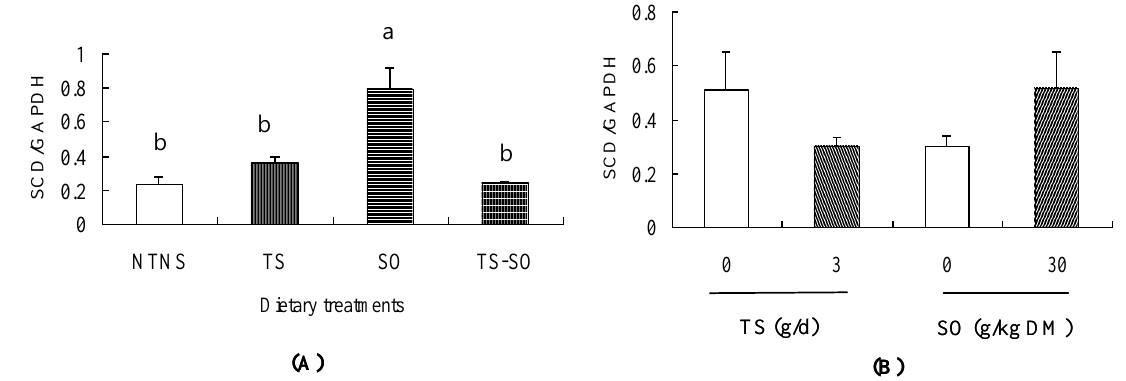
Figure 1. The mRNA abundance of stearoyl-CoA desaturase (SCD) relative to glyceraldehyde-3-phosphate dehydrogenase (GAPDH) in longissimus dorsi muscle from growing lambs with different additives: no tea saponins or soybean oil (NTNS), tea saponins (TS, 3 g/kg DM), soybean oil (SO, 30 g/kg DM), and tea saponins plus soybean oil (TS-SO). (A) Multiple comparisons of means among treatments analyzed by Duncan’s multiple range tests. a,b Means with different letter differ significantly (p<0.05). (B) Results by analysis of variance including the effects of TS, SO and their interaction; P TS = 0.019, P SO = 0.016, P TS  SO =